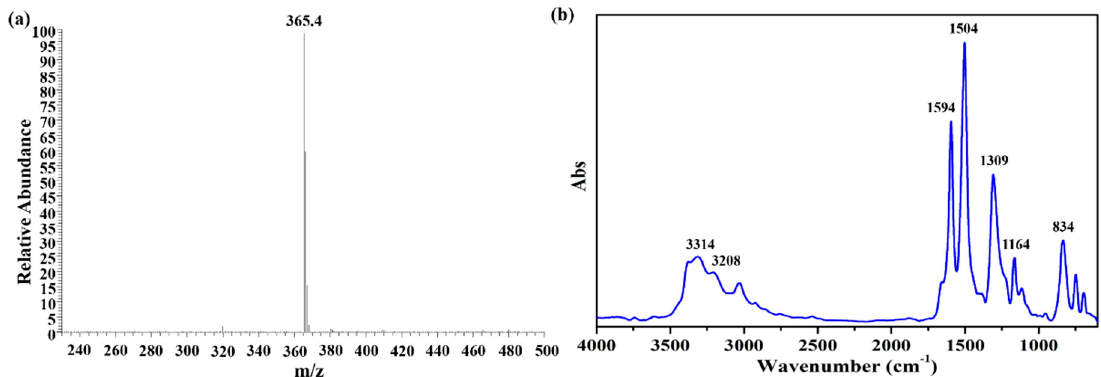
Figure 1. Characterization of aniline tetramer by ( a ) Mass and ( b ) ATR-FTIR spectroscopies.